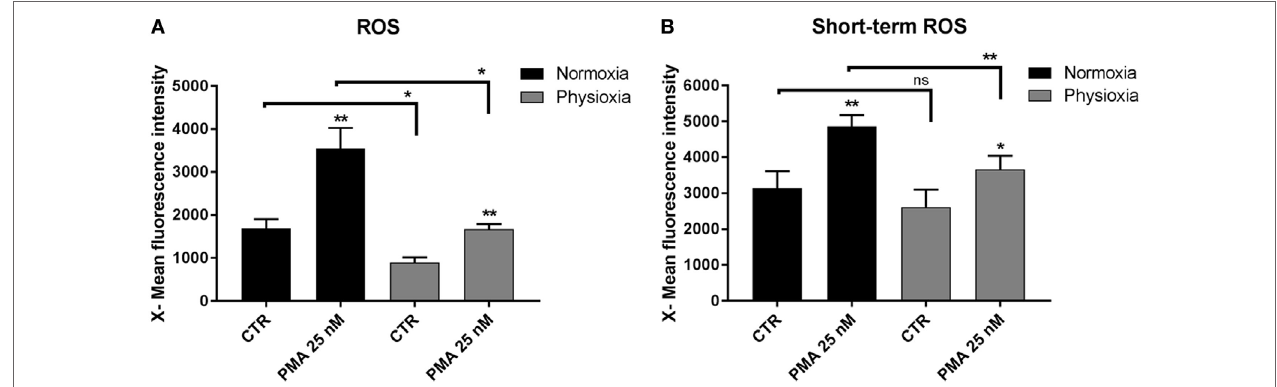
FiGUre 4 | (a) Reactive oxygen species (ROS) production of mast cells (MCs) differentiated under physioxia compared to normoxia. The results display that PMA (25 nM) induces ROS production in MCs in both conditions. By comparing physioxic versus normoxic differentiated MC, ROS production is significantly and drastically reduced. Depicted are mean values and SEM from cells of n = 4 (eight mice, two mice pooled for each batch) experiments for normoxic cultivated MCs and n = 3 (six mice, two mice pooled for each batch) for physioxic cultivated MCs. (B) ROS production of MCs differentiated under normoxia and pre-incubated for 3 h (short-term) under physioxia in comparison to normoxia. PMA stimulated MCs significantly produce more ROS under short-term physioxia and normoxia. By comparing short-term physioxia versus normoxia, PMA stimulated ROS production is significantly decreased under physioxia. Depicted are mean values and SEM from cells of n = 4 (eight mice, two mice pooled for each batch) experiments. ROS production was analyzed by flow cytometry using the DCF-fluorescence based method. Depicted is the X-mean green fluorescence intensity of each cell. Differences within one group were analyzed by using a paired, two-tailed Student’s t -test.